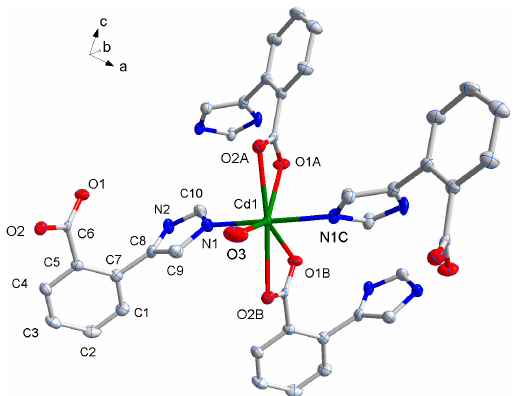
Figure 1. The coordination environment of Cd(II) ion in 1 with the ellipsoids drawn at the 30% probability level. Symmetry codes: A 1.5 − x, 0.5 + y, 0.5 − z, B 0.5 + x, 0.5 + y, z, C 2 − x, y, 0.5 − z.